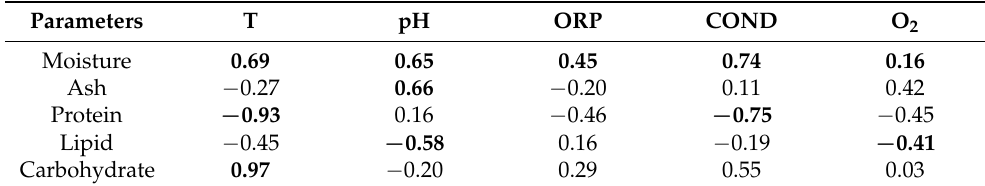
Table 4. Pearson correlation of biochemical composition with seawater parameters: temperature (T), pH, ORP (oxydo-reduction potential), conductivity (COND), oxygen (O 2 ). Statistically significant differences ( p < 0.05) are represented in bold. Parameters